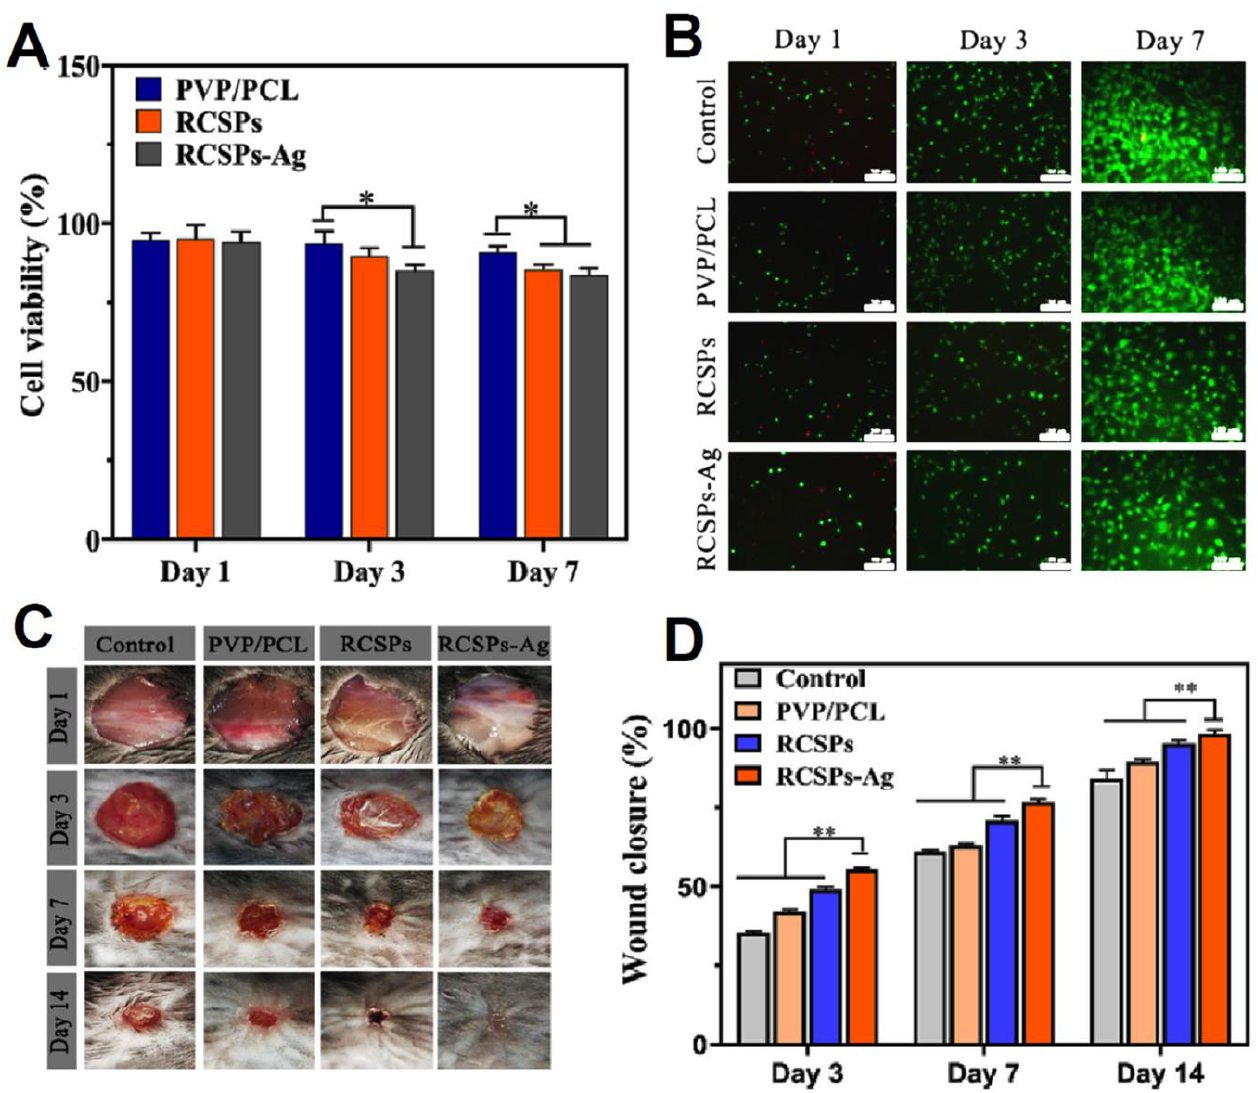
Figure 14. ( A ) Percentage of cell viability of NIH 3T3 cells treated with PVP/PCL, RCSPs, and RCSPs- Ag in different time intervals. ( B ) Confocal laser microscopy images of NIH 3T3 in different test groups. ( C ) Wound healing process images of each group within 2 weeks of treatment with various groups. ( D ) Wound Closure percentages treated with PVP/PCL, RCSPs, RCSPs-Ag nanofibers, and a control group treated with saline gauze (* p < 0.05, ** p < 0.01). Reproduced from Ji et al. [206], with permission from Elsevier.